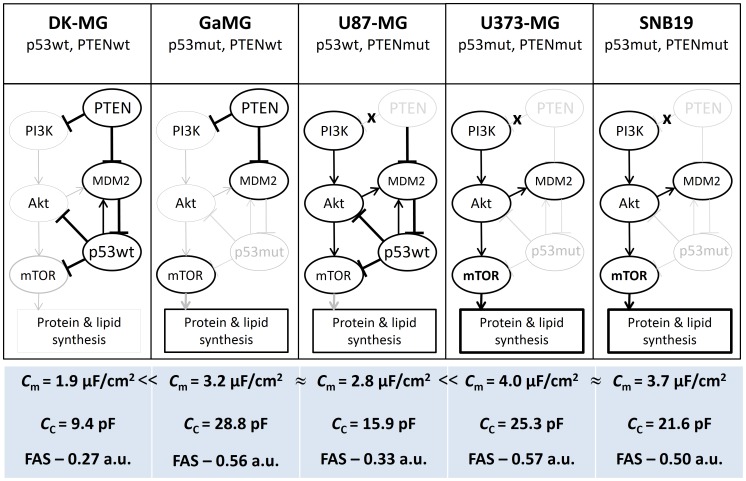
Simplified diagram of putative signaling pathways accountable for the excessive cell membrane area/folding in 5 GBM cell lines differing in their PTEN and p53 mutation.The cell lines are arranged in ascending order according to the degree of membrane folding, probed by the area-specific membrane capacitance C
m. Resulting from the deficiency of either PTEN (U87-MG), p53 (GaMG), or both proteins (U373-MG and SNB19), the overexpression of mTOR (Figure 6) promotes synthesis of proteins and lipids which can be used for the plasma membrane production. The amplified membrane synthesis may lead to the excessive membrane area and folding as reflected, respectively, by a very large C
C value of GaMG cells and increased C
m data of U373-MG and SNB19 cells. In addition to deregulation of the PI3K/AKT/mTOR and p53 pathways, the large surface areas of GaMG and U373-MG cells (C
C = 28.8 and 25.3 pF) may be associated with the increased levels of fatty acid synthase (FAS, 0.56–0.57 a.u.), a key enzyme of the lipogenic pathway.